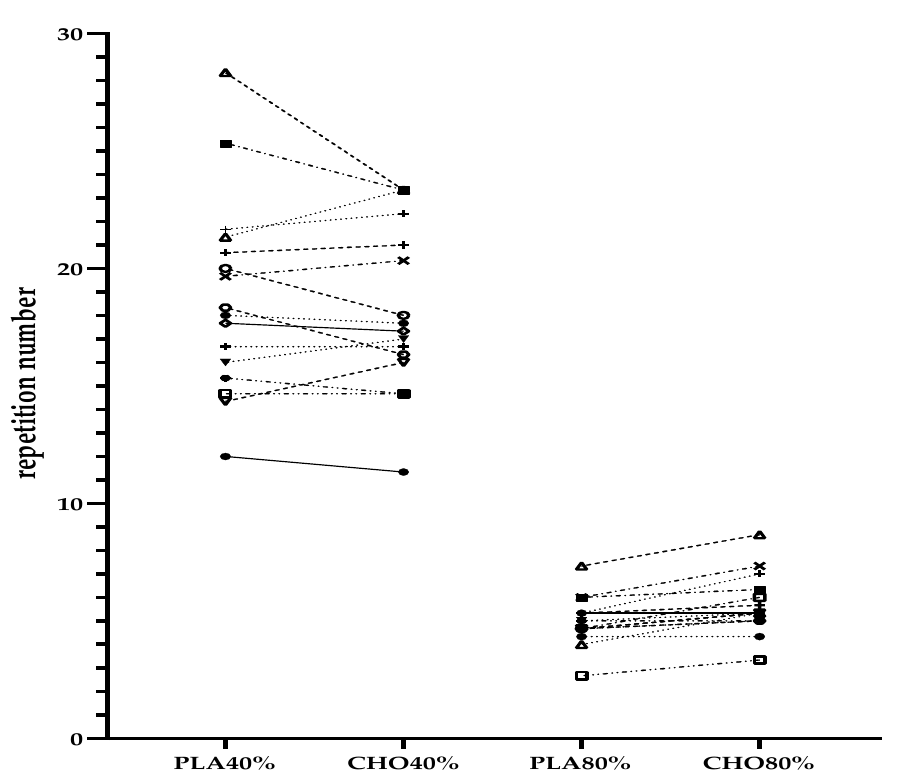
Figure 3. Individual data of mean of three sets of bench press endurance test. PLA40%: placebo rinse at 40% 1 RM endurance; CMR40%: carbohydrate rinse at 40% 1 RM endurance; PLA80%: placebo rinse at 80% 1 RM endurance; CMR80%: carbohydrate rinse at 80% 1 RM endurance.